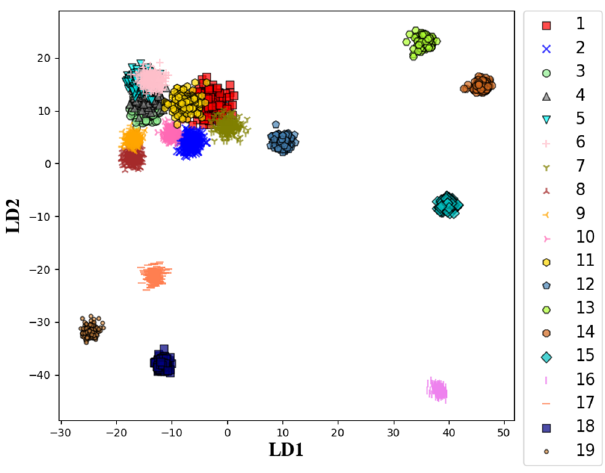
Figure 4. The projection of AE spectrums on a two-dimensional feature space.